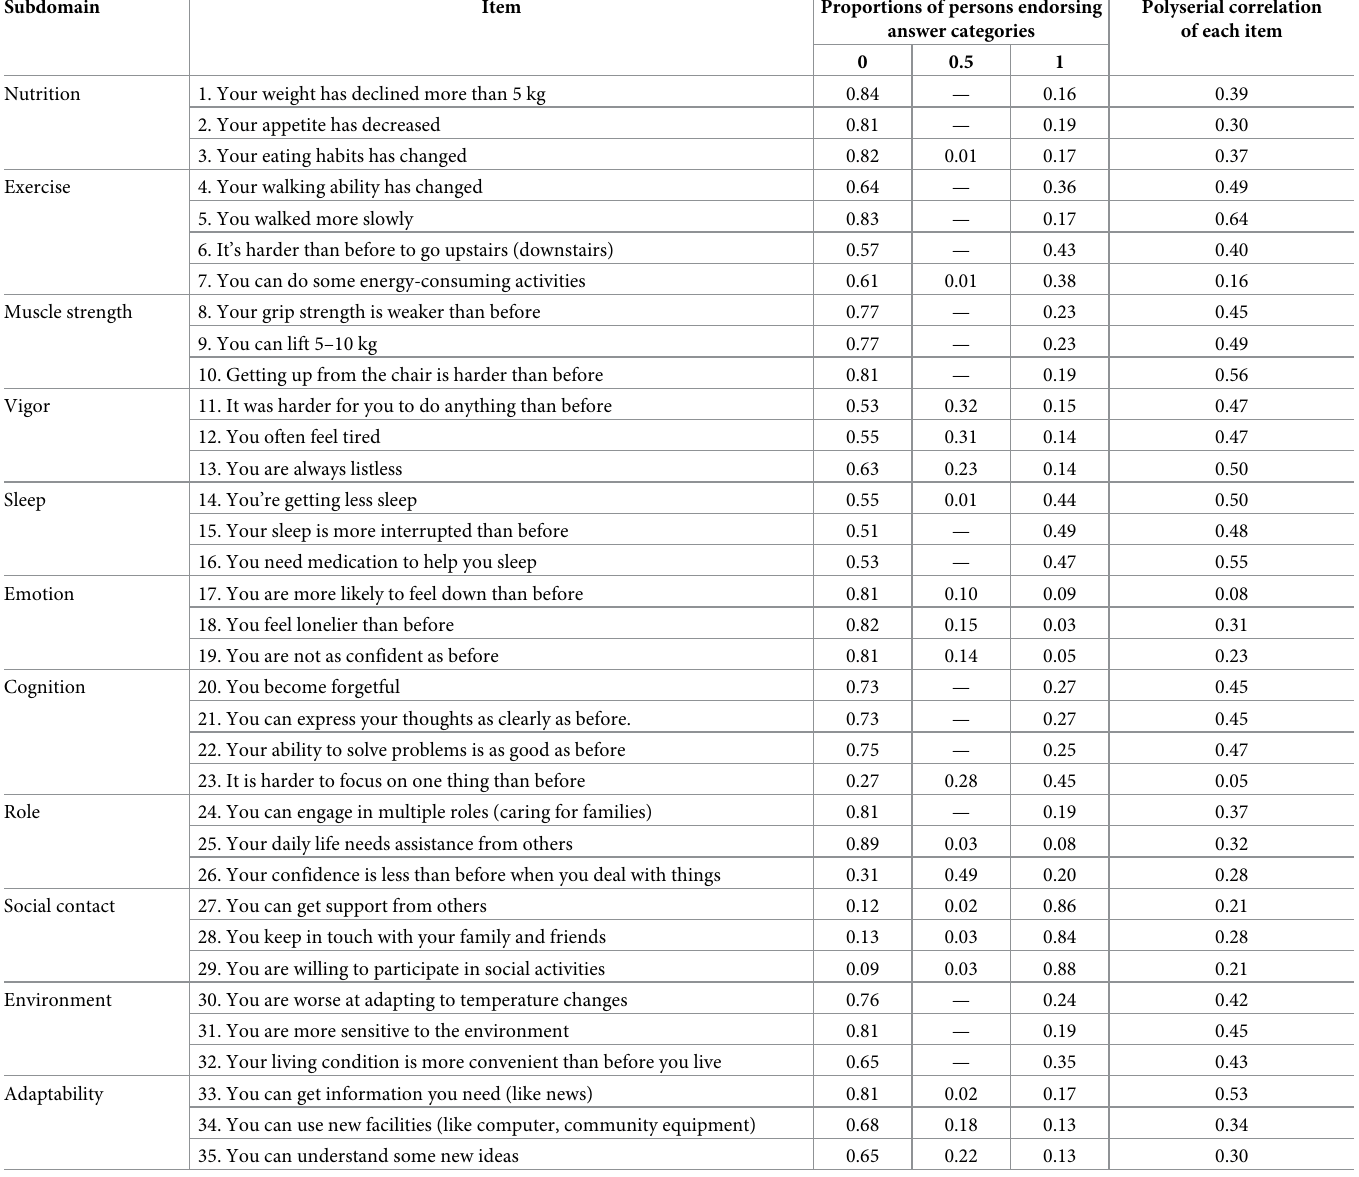
Table 2. Descriptive data for the items of the FI-35. Subdomain Item Proportions of persons endorsing